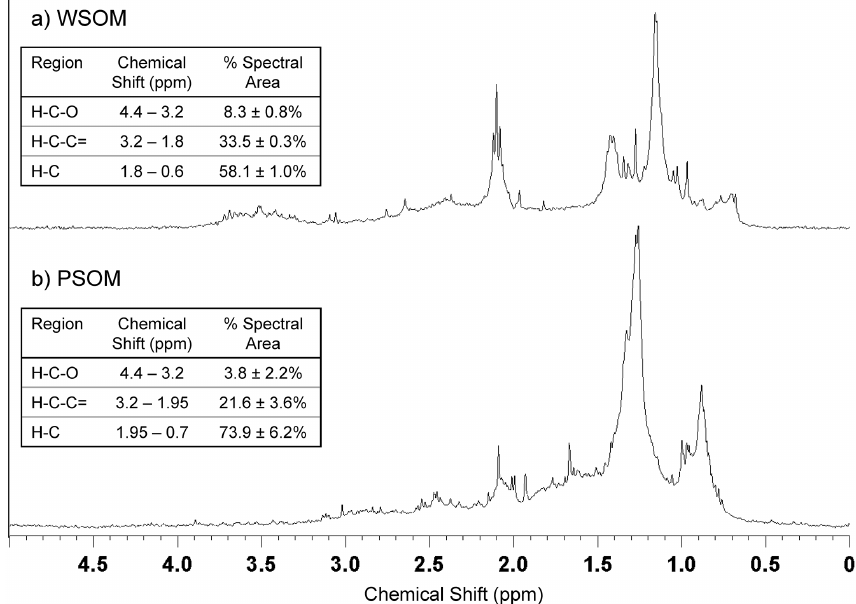
Figure 1. Expanded 1 H NMR spectra between 0 and 5ppm for (a) WSOM and (b) PSOM for the aerosol particulate sample collected 25–26 June 2013. The table insets give the chemical shifts and average relative intensities (normalized to total intensity between 0 and 4.4ppm) and standard deviations for the three aerosol samples in the major proton regions, including aliphatic (H-C), unsaturated (H-C-C = ), and oxygenated aliphatics